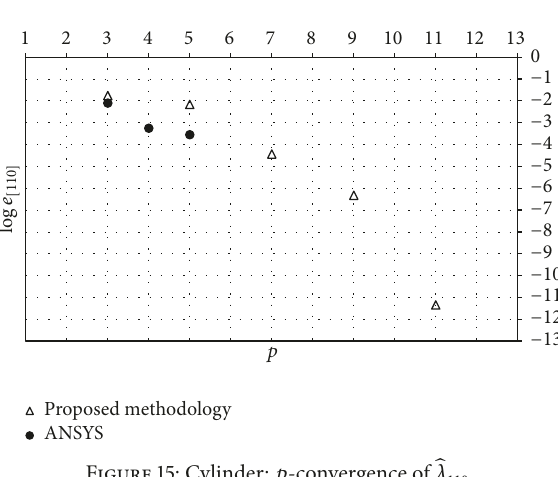
Figure 14: Cylinder: